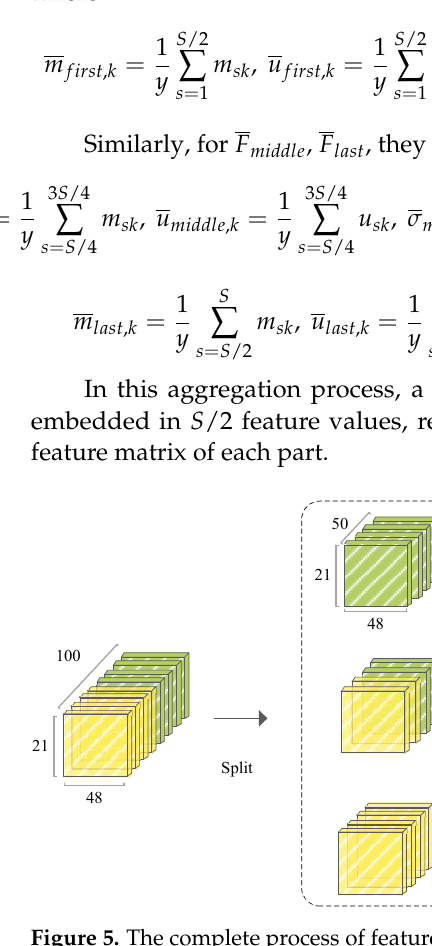
Figure 5. The complete process of feature